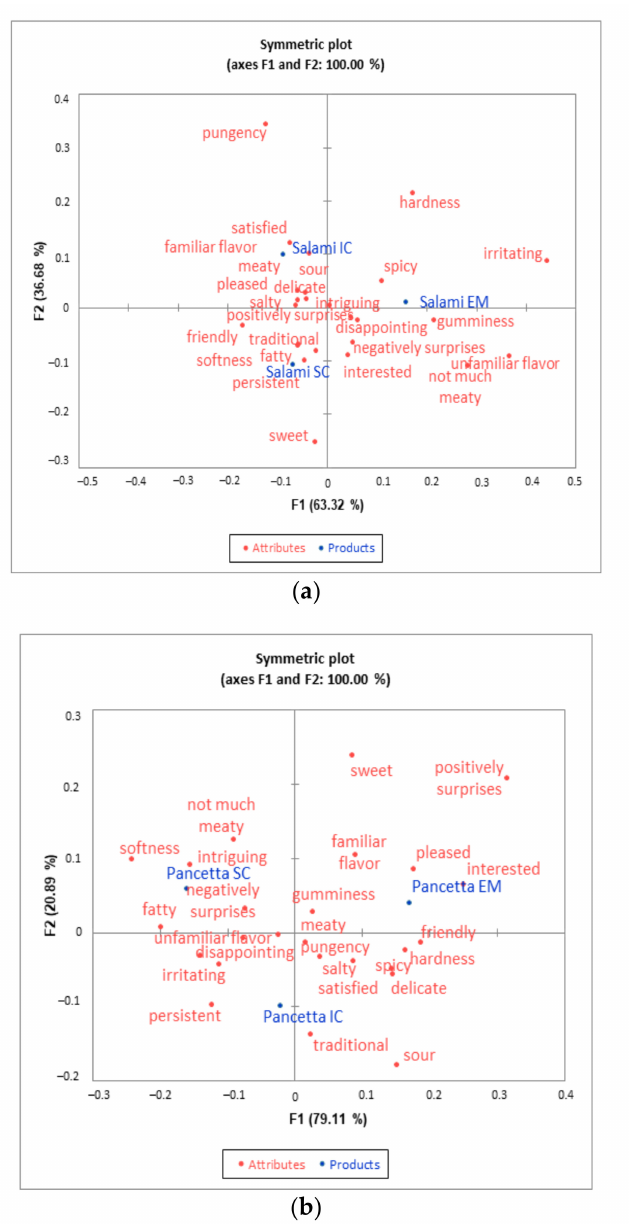
Figure 4. Representation of the salami ( a ) and pancetta ( b ) samples and the attributes in the first and second dimensions of the correspondence analysis obtained from the CATA total frequency